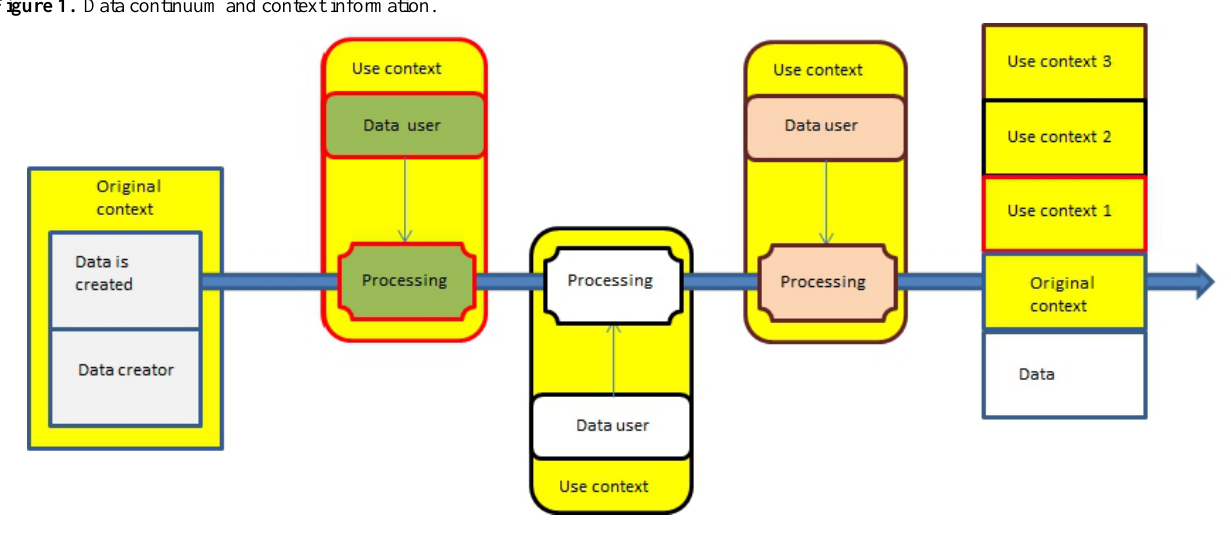
Figure 1. Data continuum and context